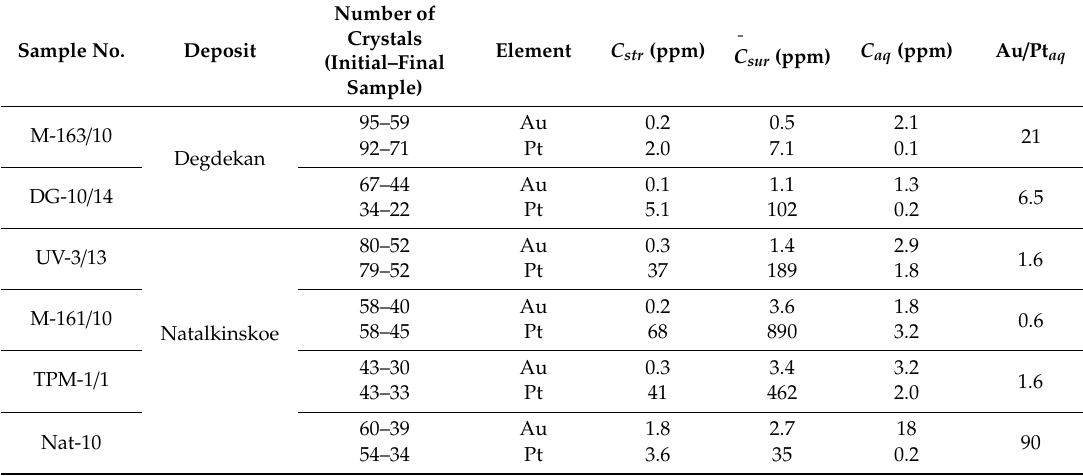
Table 7. Evaluation of gold and platinum grade in ore-forming fluids by pyrite composition using experimental distribution coe ffi cients D str